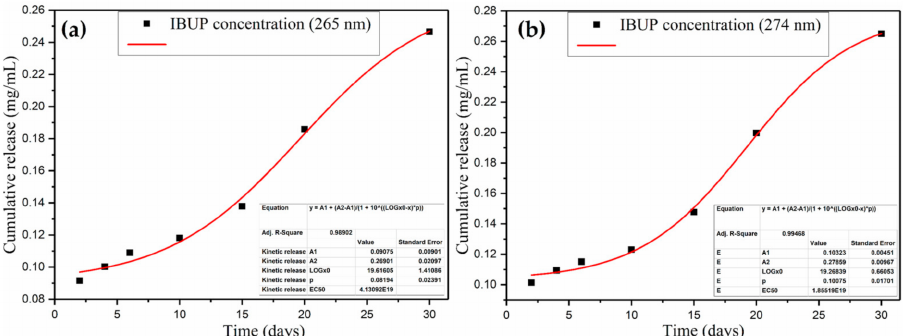
Figure 4. Cumulative release of Ibuprofen from PLGA/IBUP coatings during biologically simulated